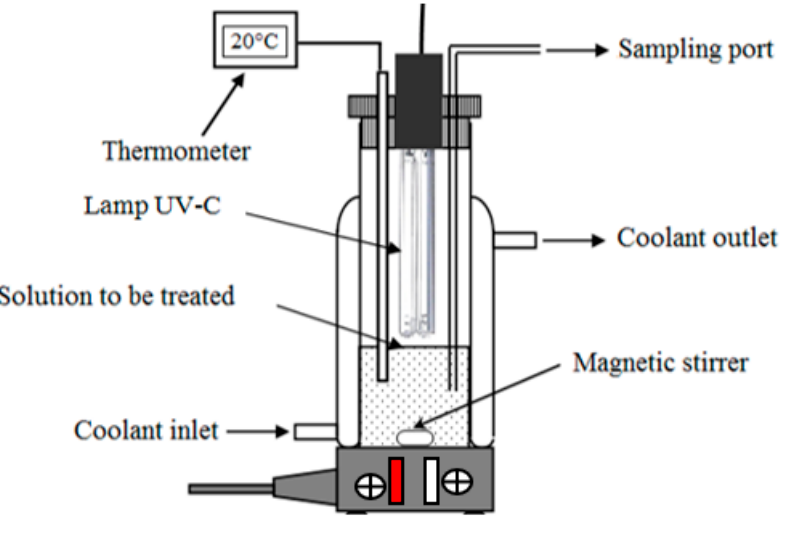
Figure 2. AO10 degradation photoreactor.